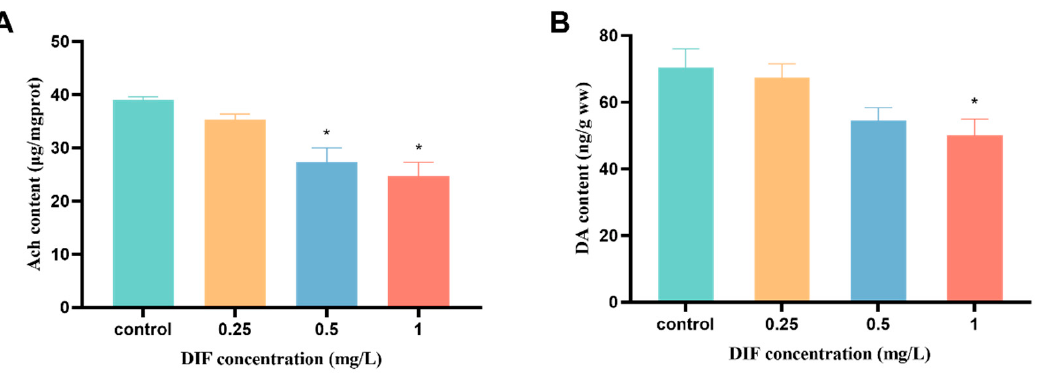
Figure 4. Concentrations of ACh ( A ) and DA ( B ) measured in zebrafish embryos exposed to difenoconazole (0, 0.25, 0.5, and 1 mg/L) until 120 h. Values are expressed as mean ± SEM of 3 replicates (200 larvae/replicate). * p < 0.05 indicates significant differences between exposure groups and the control group.